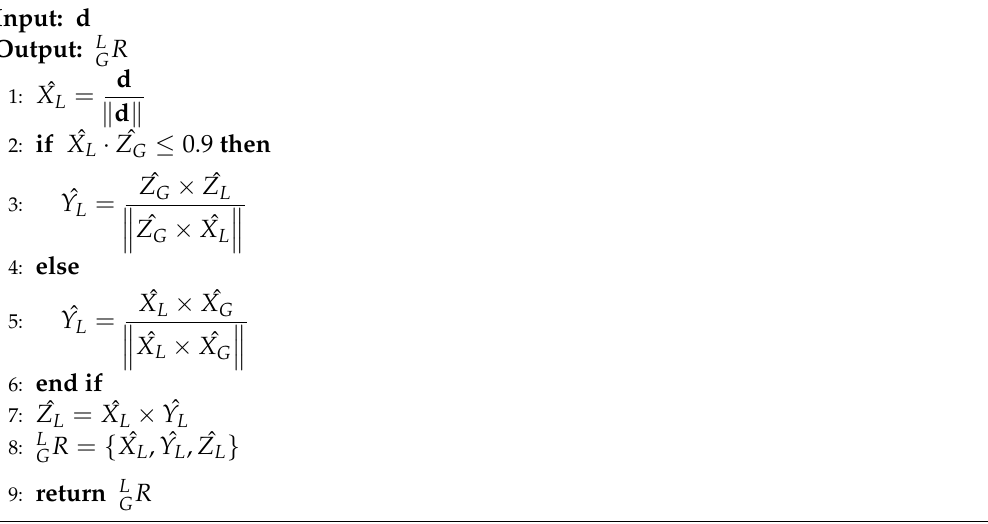
Algorithm 1 Generate a rotation matrix to transform from the local coordinate frame into the global coordinate frame. The z axis is used to calculate a vector orthogonal to d . The exception is to avoid precision issues with the cross-product due to collinearity. The final axis is orthogonal to both directions and the previously found axis. The vector ˆ Z L is always pointing as vertical as possible. The algorithm is applied to each set of start and end positions as the rotation is the same for both local